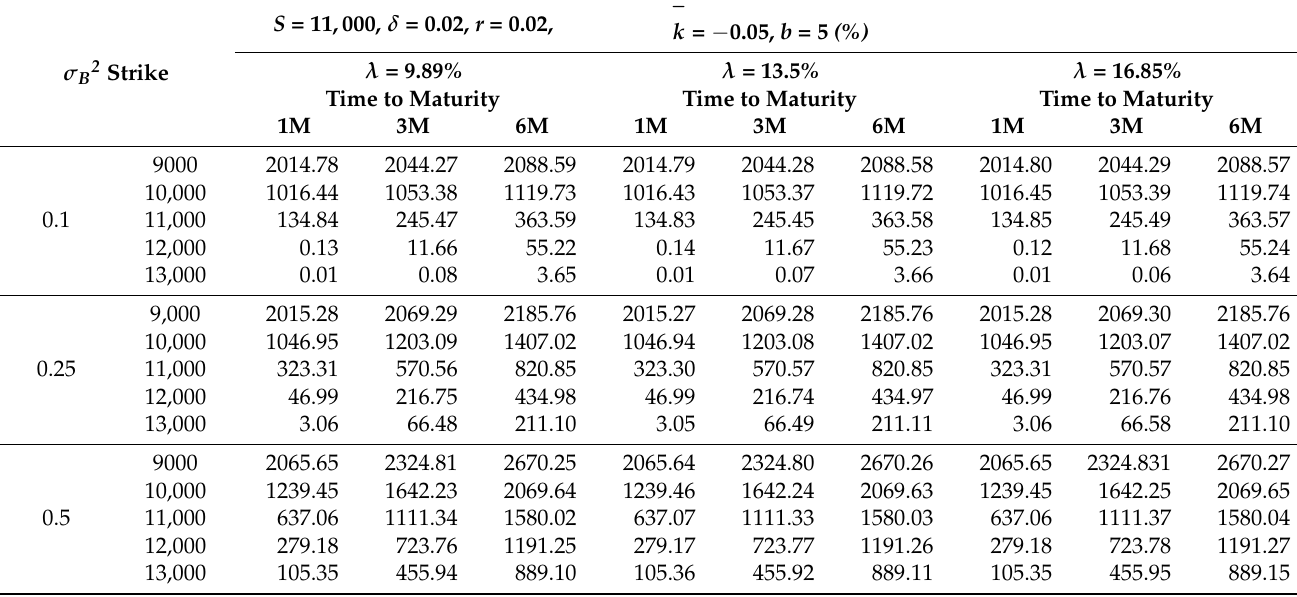
Table 2. Calculating Bitcoin Call Option Valuation with Merton Jump-Diffusion.